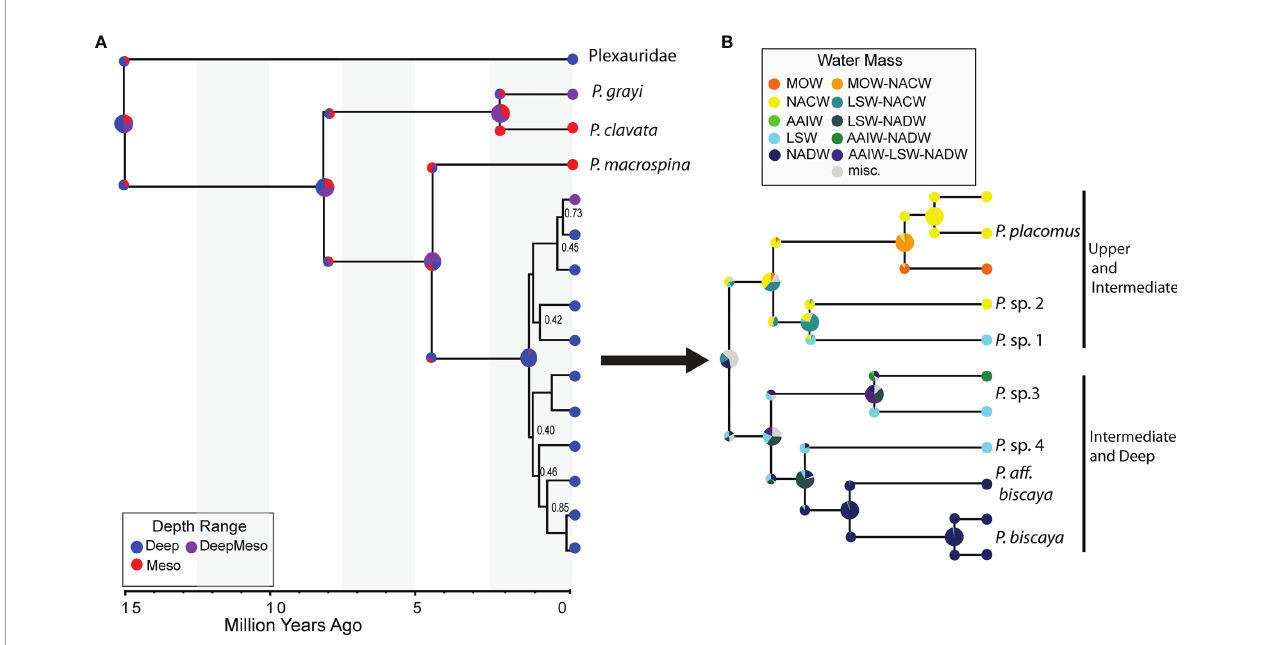
FIGURE 5 | Ancestral range estimates of (A) depth and (B) water mass constructed using the Dispersal-Extirpation-Cladogenesis model in RevBayes overlain onto the SNAPP species tree ( Figure 3 ). Water mass reconstructions shown are for the deep-sea (>200 m) clade only. Nodes are annotated with ancestral ranges (pie charts) before and after cladogenic events. Tips are annotated with contemporary distributions. Depth Range: Deep=>200 m, Meso=0-200 m; DeepMeso=0->200 m. Water Mass Range: MOW, Mediterranean Over fl ow Water; NACW, North Atlantic Central Water; AAIW, Antarctic Intermediate Water; LSW, Labrador Sea Water; NADW, North Atlantic Deep Water; misc, more than two